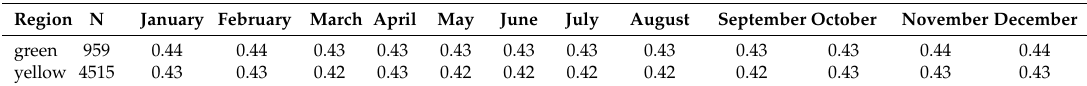
Table 2. Number of points for the two clusters and mean PAR/global horizontal irradiance (GHI) values for the different months (N: Number of points).